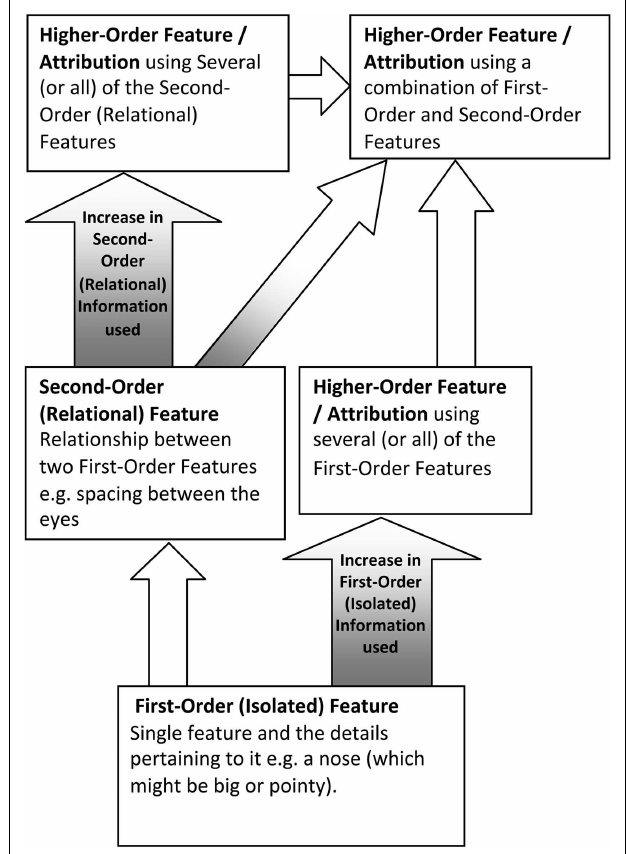
FIGURE 1 |An interpretation of a relational/configural model of face perception integrating the Diamond and Carey (1986) and Rhodes (1988) models. The model starts with first-order (isolated) features (that are processed in a part-based manner), moves on to the emergence of second-order (relational) features (that are subject to configural processing), and finishes with increasingly complex higher-order features (attributions) which can involve a combination of first and/or second-order